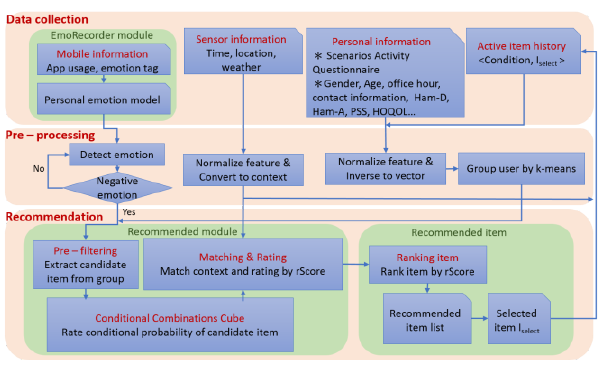
Figure 2. System flow